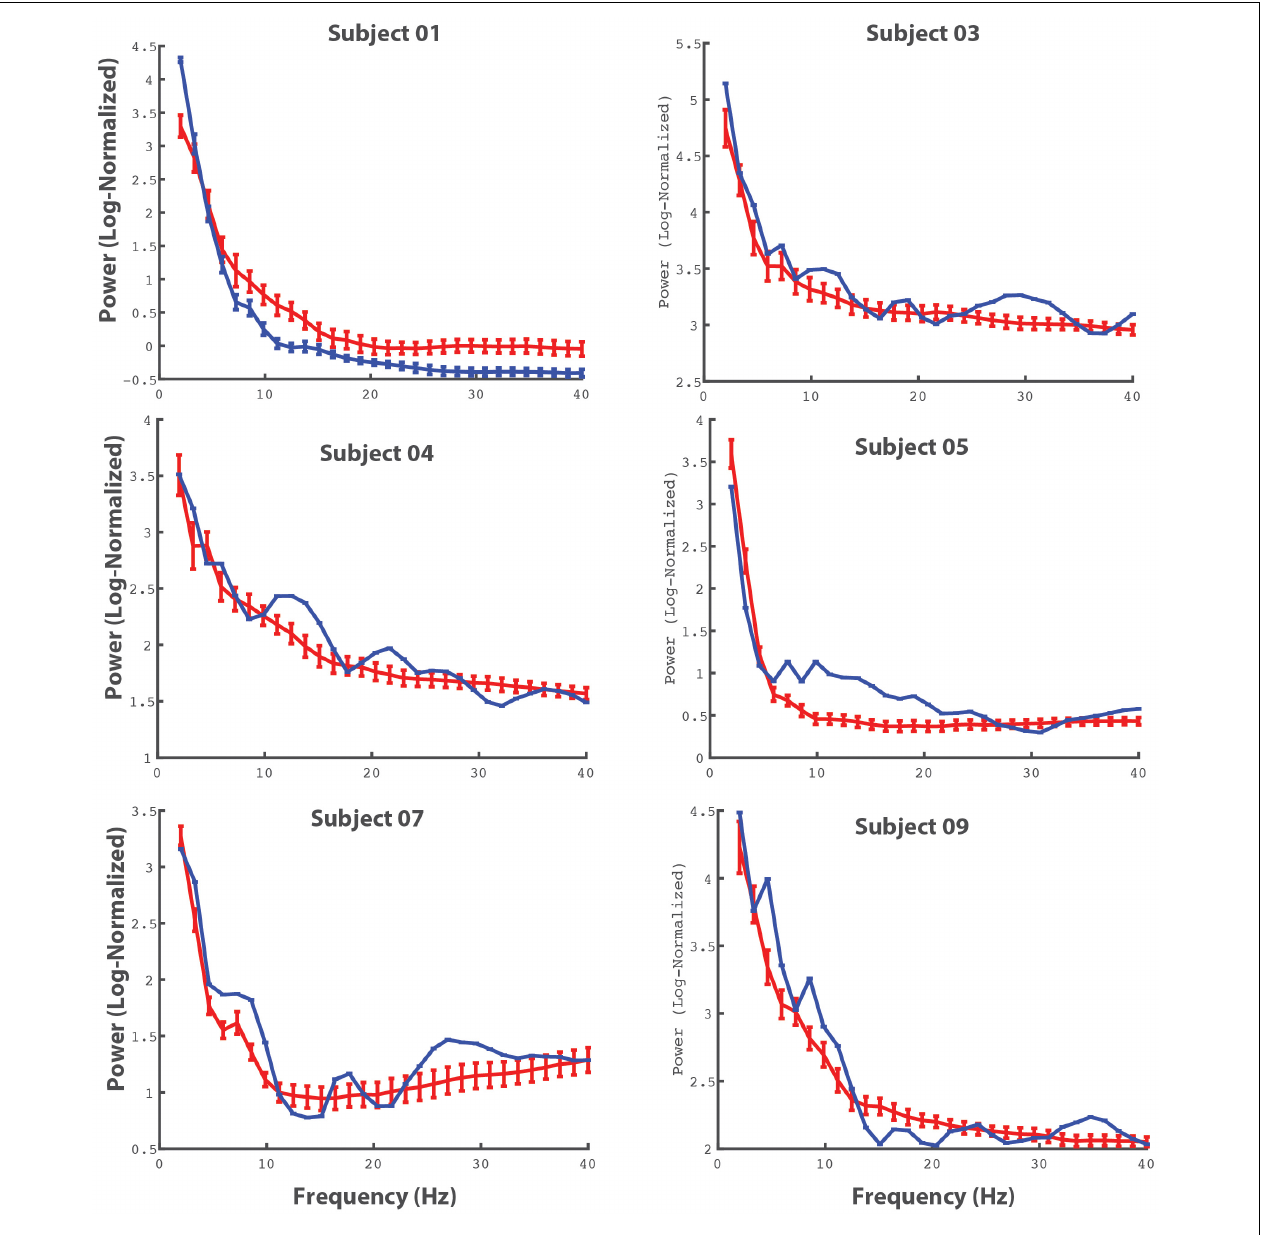
FIGURE 9 | Averaged cervical power spectra during movement and baseline activity. The power spectra for individual electrodes (for all patients in with electrodes in the cervical spine) are shown. The red lines represent power spectra averaged across movement events (bilateral upper extremity elbow flexion) and the blue lines represent power spectra during periods of rest. The errorbars reflect 95%